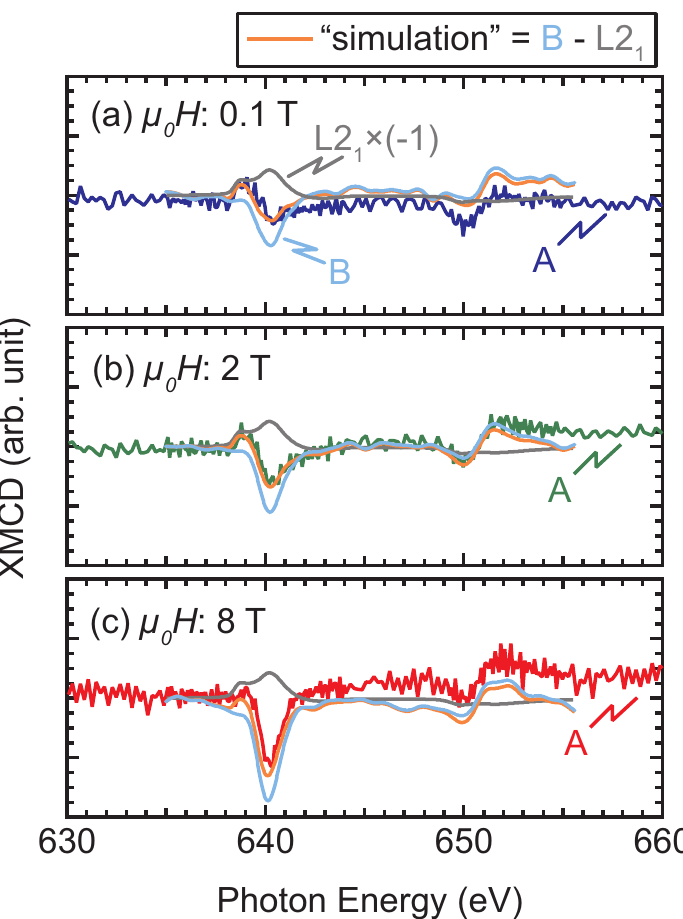
Figure 10. Decomposition of XMCD spectra of Sample A (annotated as “A”) using those of L2 1 - Mn 2 VAl and Sample B (annotated as “L2 1 ” and “B”, respectively). The spectrum of L2 1 -Mn 2 VAl was obtained from the Ref. [32] with permission from American Phyical Society, 2018, in which a magnetic field of 2 T was applied for the measurement. The blue, green, and red spectra in panels ( a – c ), respectively, are the original data of Sample A shown in Figure 6a. The spectra of Sample B in each panel were smoothed and multiplied by a factor of 1.2 from the results shown in Figure